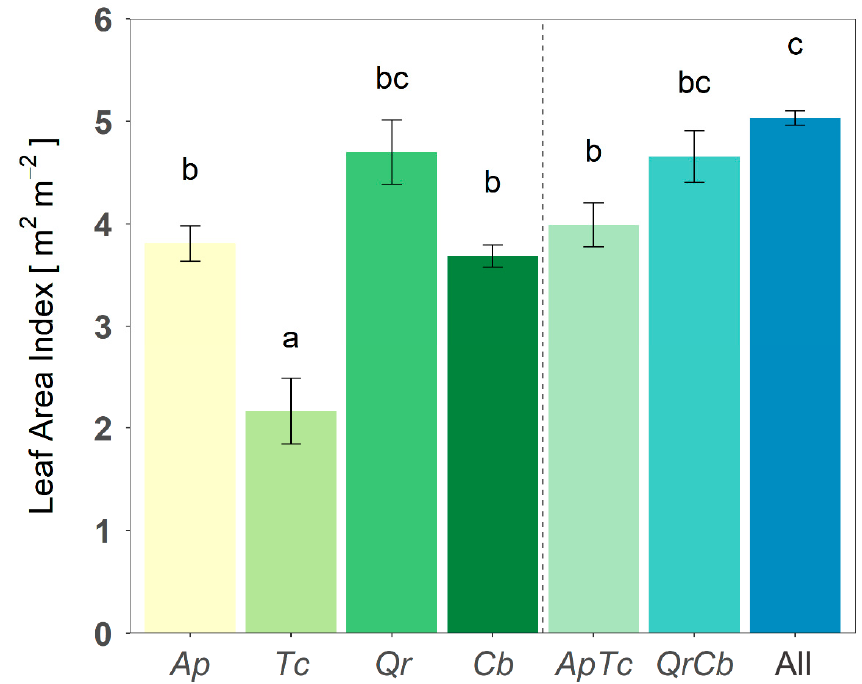
Figure 2. Differences in mean Leaf Area Index (LAI) in m 2 · m − 2 of monocultures ( Ap , Tc , Qr , Cb ), two species polycultures ( ApTc , QrCb ) and a four species polyculture (All) consisting of the four species Acer platanoides ( Ap ), Tilia cordata ( Tc ), Quercus robur ( Qr ), Carpinus betulus ( Cb ). Each bar represents the mean LAI of four replicates. Error bars refer to the standard error (SE) of the mean. Letters mark significant differences of the mean LAI between compositions (Table 1). Significant differences in the monocultures occurred only between T. cordata and the other species, see Table 1.